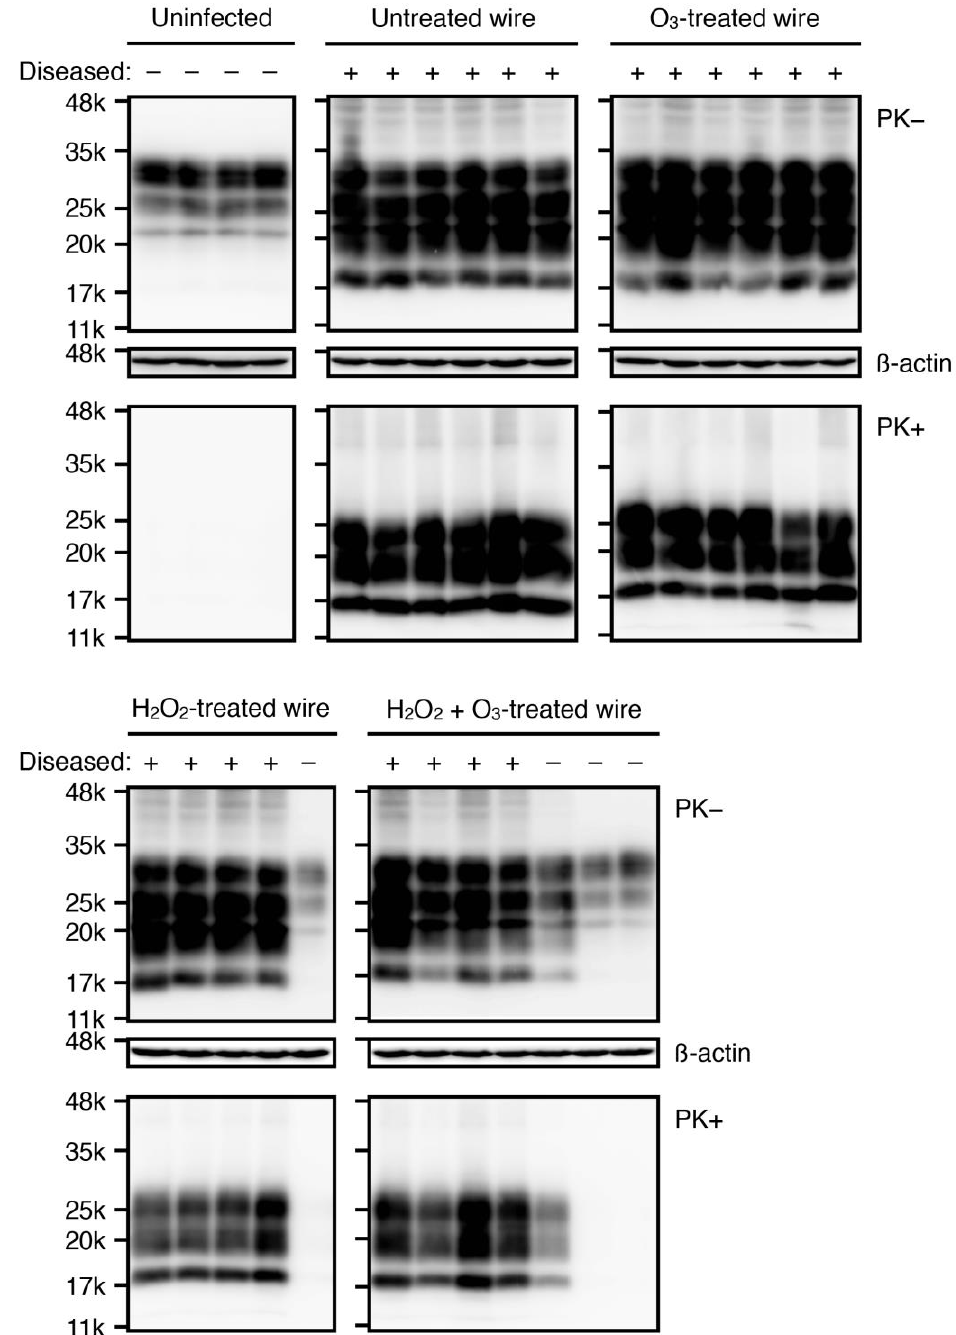
Figure 2. Western blotting for PrP Sc in the brains of mice implanted with various gas-treated, RML prion-contaminated stainless steel wires. Brain homogenates from mice uninfected with RML prions ( n = 4), implanted with gas-untreated, RML prion-contaminated stainless steel wires ( n = 6), ozone gas-treated, RML prion-contaminated stainless steel wires ( n = 6), vaporized hydrogen peroxide-treated, RML prion-contaminated wires ( n = 5), and ozone gas mixed with vaporized hydrogen peroxide-treated, RML prion-contaminated wires ( n = 7) were treated with or without proteinase K (PK) and subjected to Western blotting with 6D11 anti-PrP antibody. β -actin is an internal control for Western blotting. O 3 , ozone; H 2 O 2 , hydrogen peroxide.